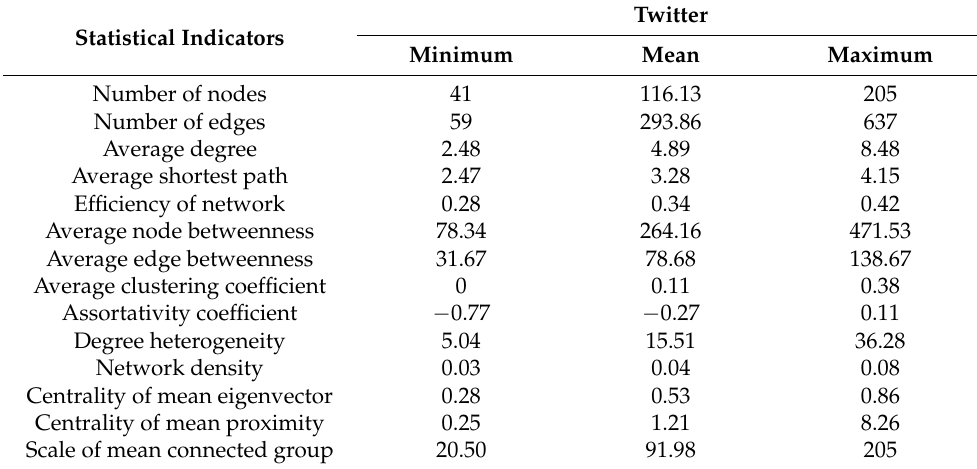
Table 2. Statistical information of network samples in